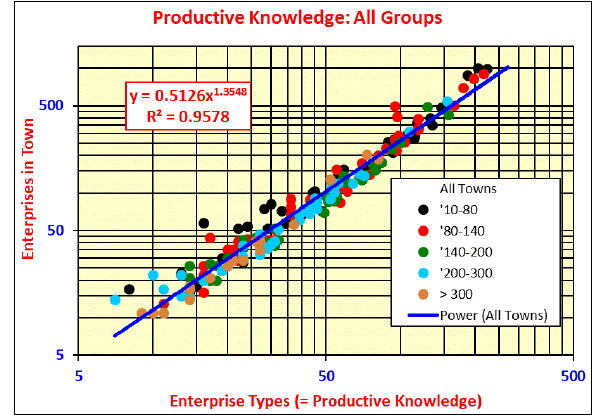
figure 4: Productive knowledge, measured by the enterprise richness of 188 South African towns, as a driver of the enterprise types– total enterprises